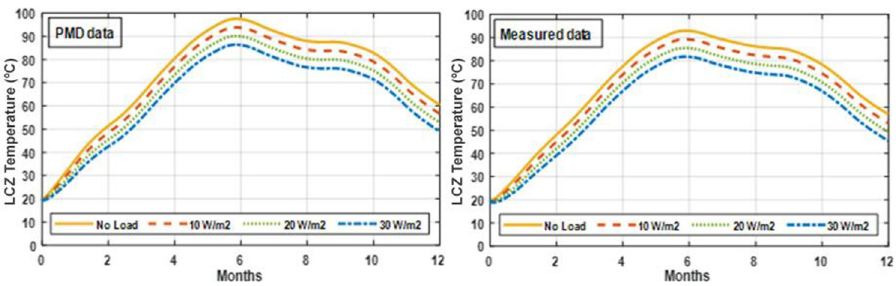
Fig 17. Energy rate extraction from the pond under PMD and measured climatic conditions of Lahore.